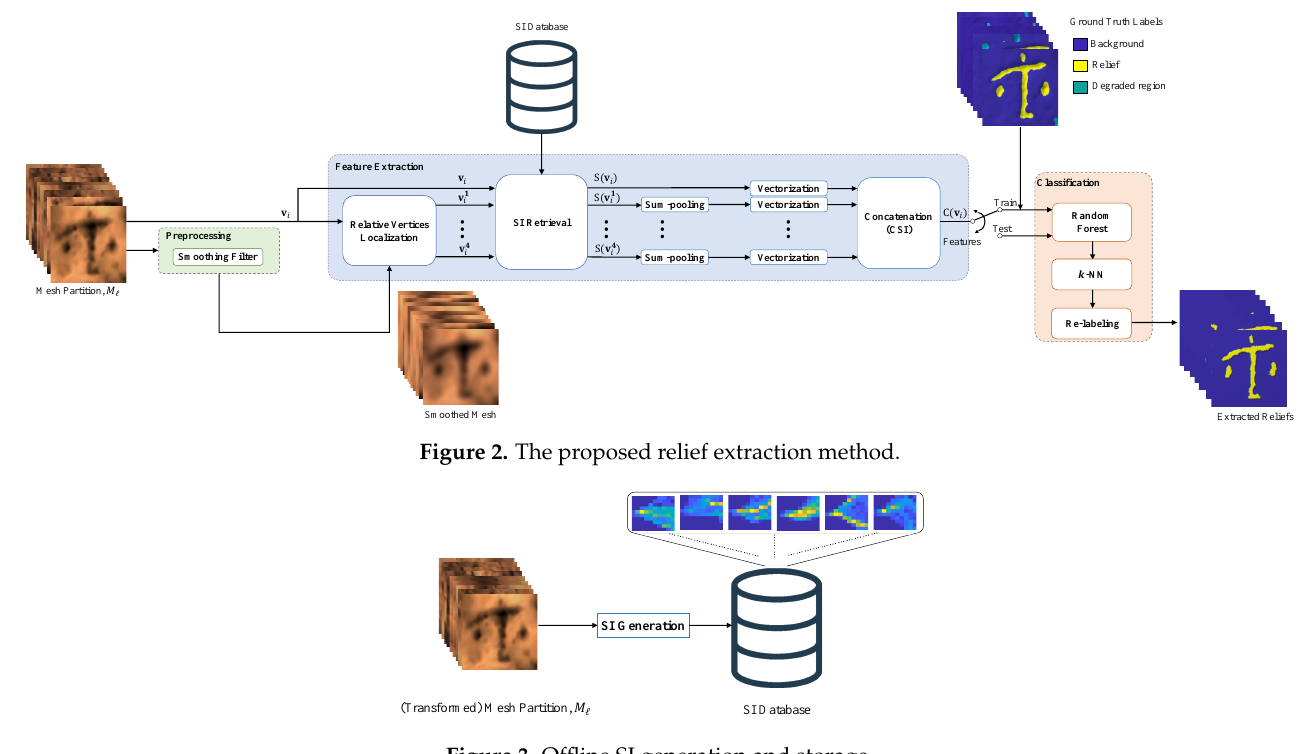
Figure 3. Offline SI generation and